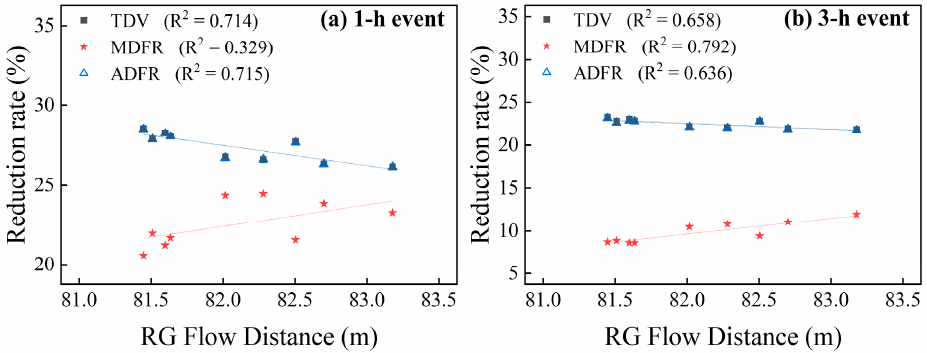
Figure 14. Effect of rain gardens’ position along the flow direction on TDV, ADFR and MDFR: ( a ) 1 h rainfall event; ( b ) 3 h rainfall event.